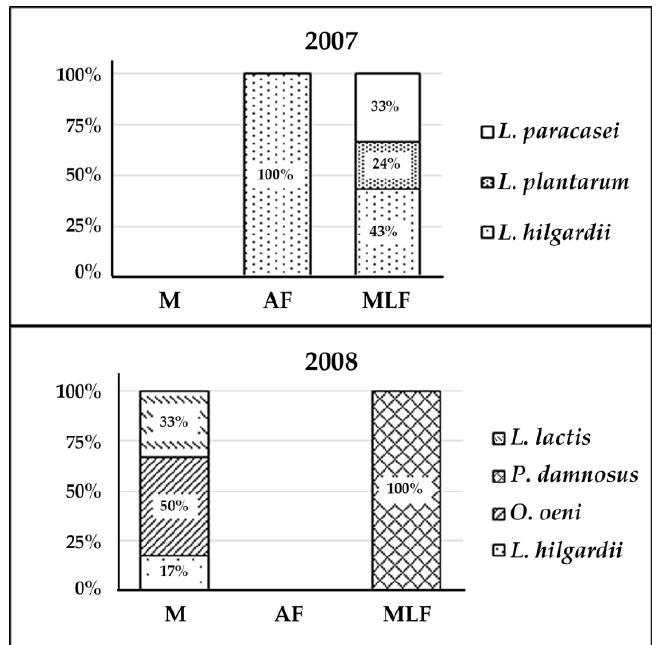
Figure 1. Annual distribution and frequency (%) of species of isolated lactic acid bacteria. M: must; AF: alcoholic fermentation; MLF: malolactic fermentation.